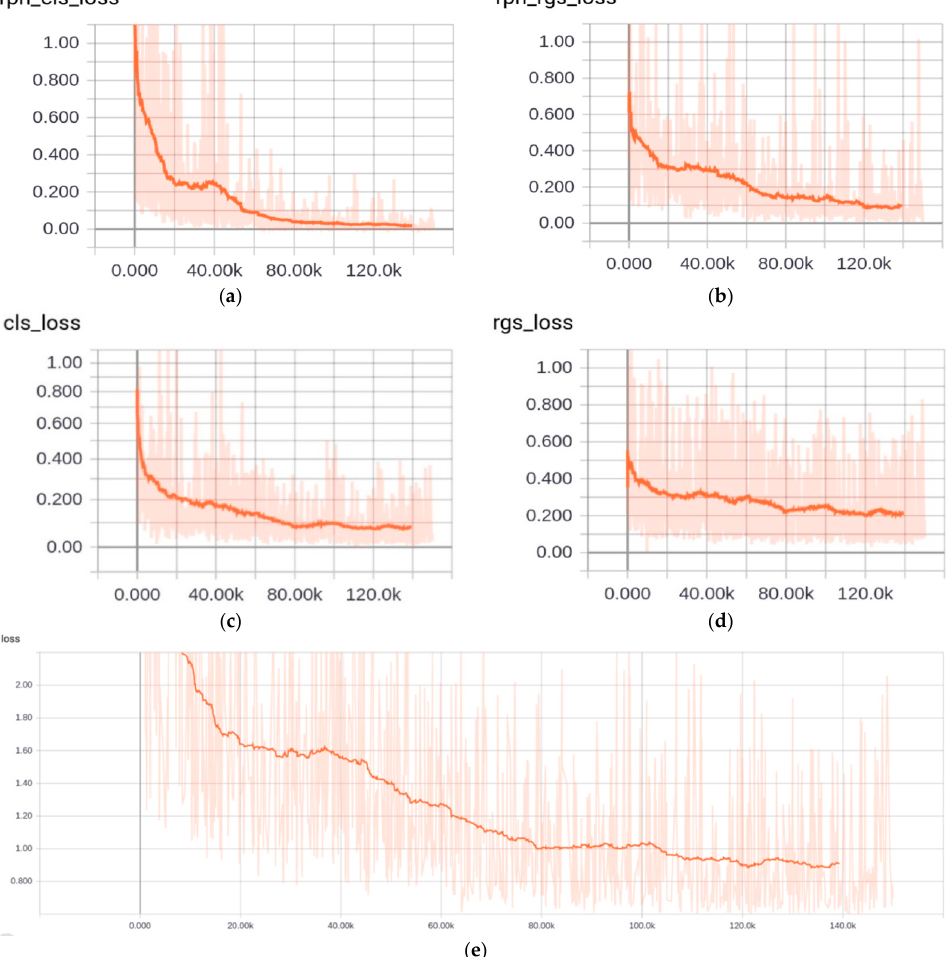
Figure 3. The curves of loss function in the processing of our training. ( a ) is the classification loss in RPN. ( b ) is the regression loss in RPN. ( c ) is the classification loss in object detection. ( d ) is the regression loss in objection. ( e ) is the overall loss which is the total of the above four losses. Table 2. The result of multi-object detection in Faster R-CNN.